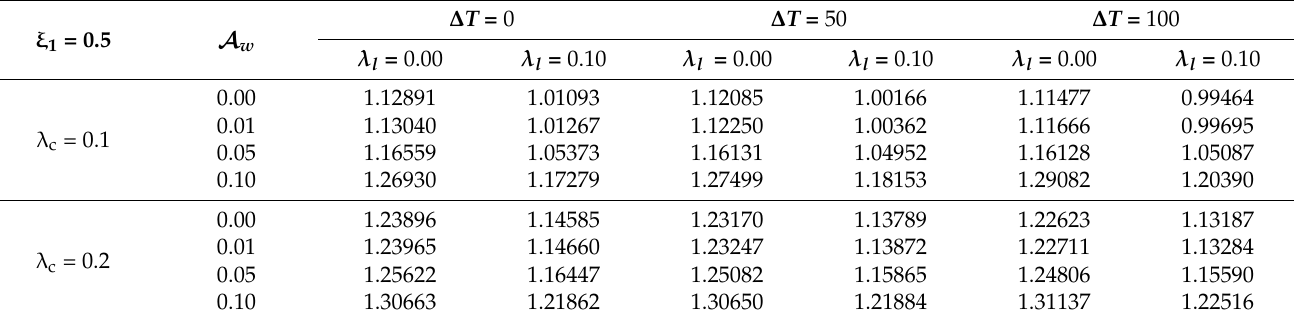
Table 10. Nonlinear dimensionless natural frequencies of porous FG clamped–clamped (C–C) nano- beam for ξ 1 = 0.5 in the case of First-Order Hamiltonian